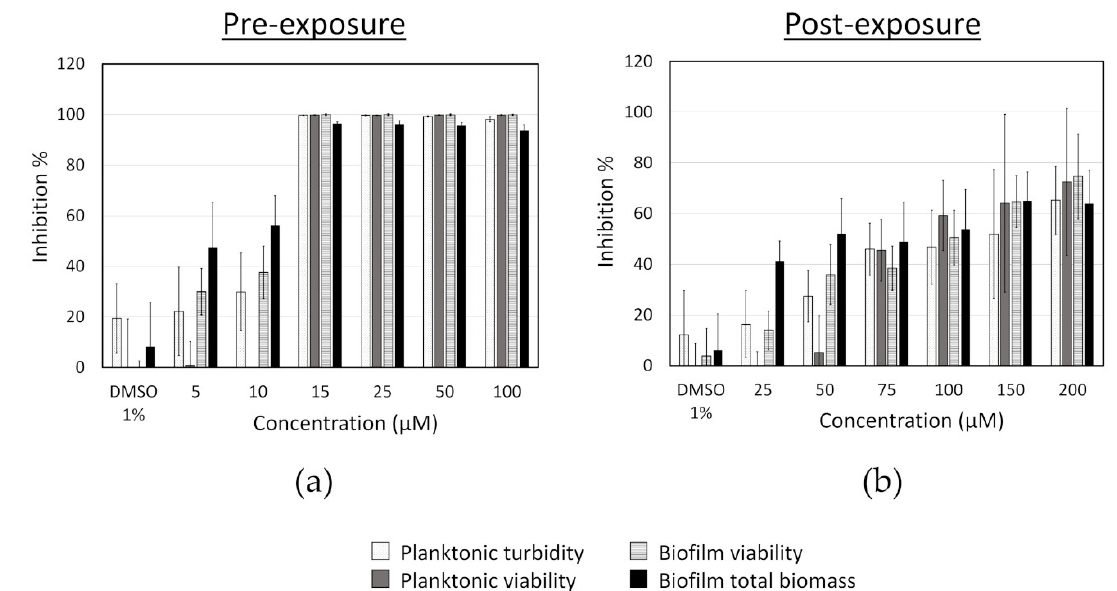
Figure 3. Inhibition of S. aureus in pre-exposure ( a ) and in post-exposure ( b ) assays caused by different concentrations of fingolimod. Results are expressed as the average inhibition percentage of the planktonic cells or the biofilms in comparison with the untreated controls ± SD. Results are from four distinct experiments with two to three technical replicates each.